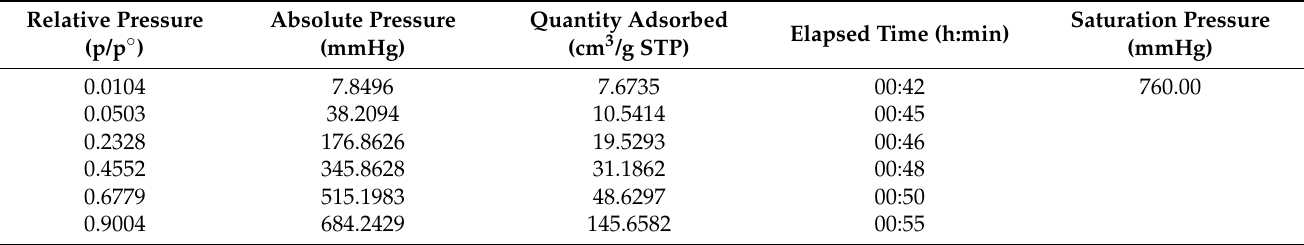
Table 2. BET surface area report for N 2 adsorption over the surface of Fe 3 O 4 NHS at evacuation rate of 1000.0 mmHg/min and saturation pressure of 760.0